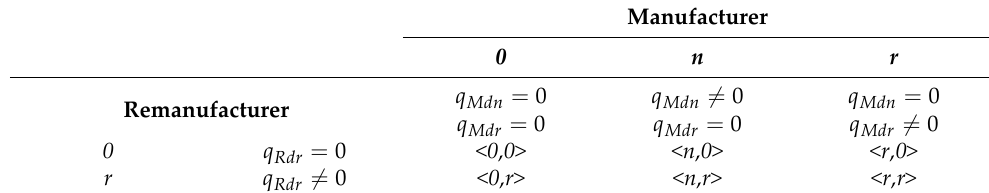
Table 3. Donation strategies.